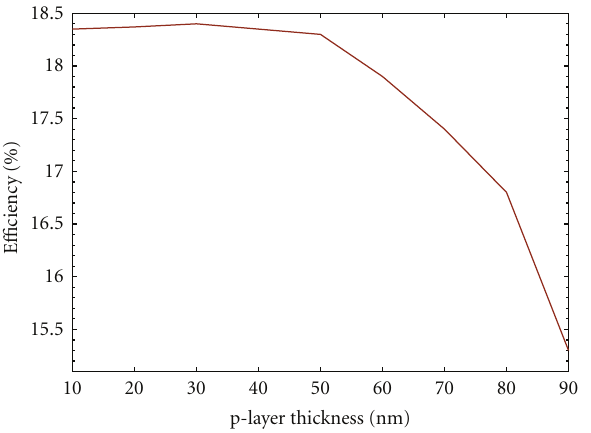
Figure 6: The a-SiGe:H solar cell e ffi ciency as a function of thick- ness of p-layer.